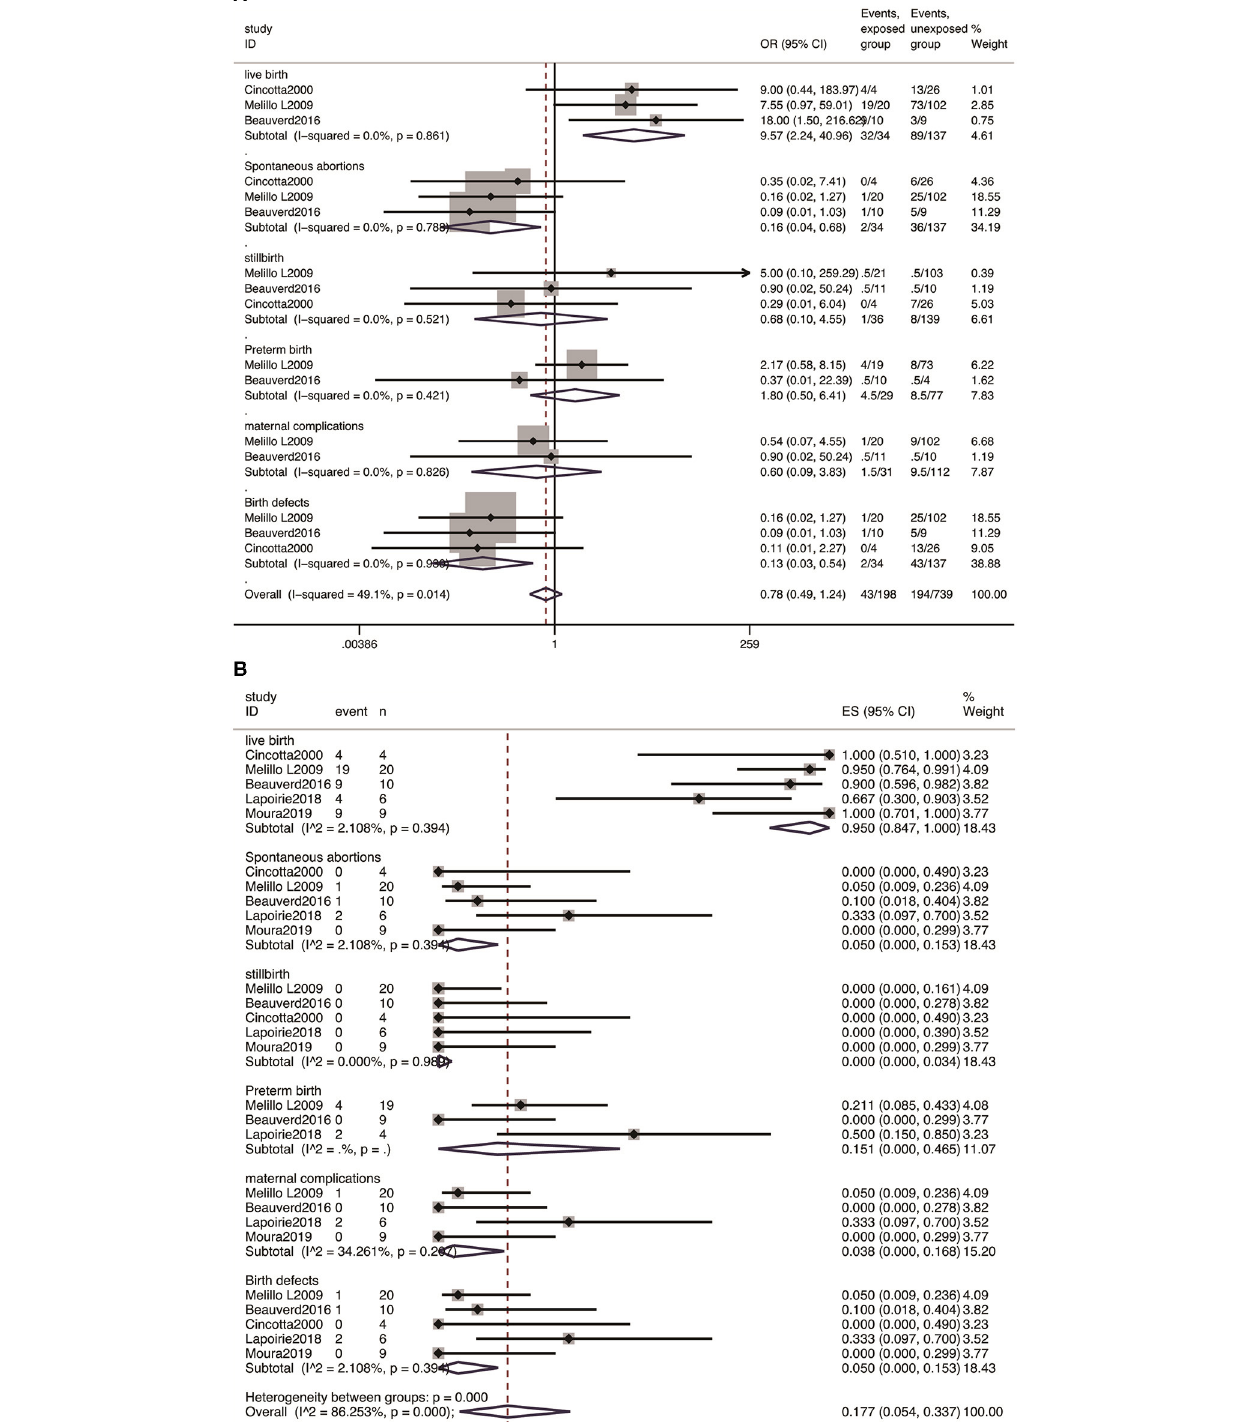
Frontiers in Reproductive Health |